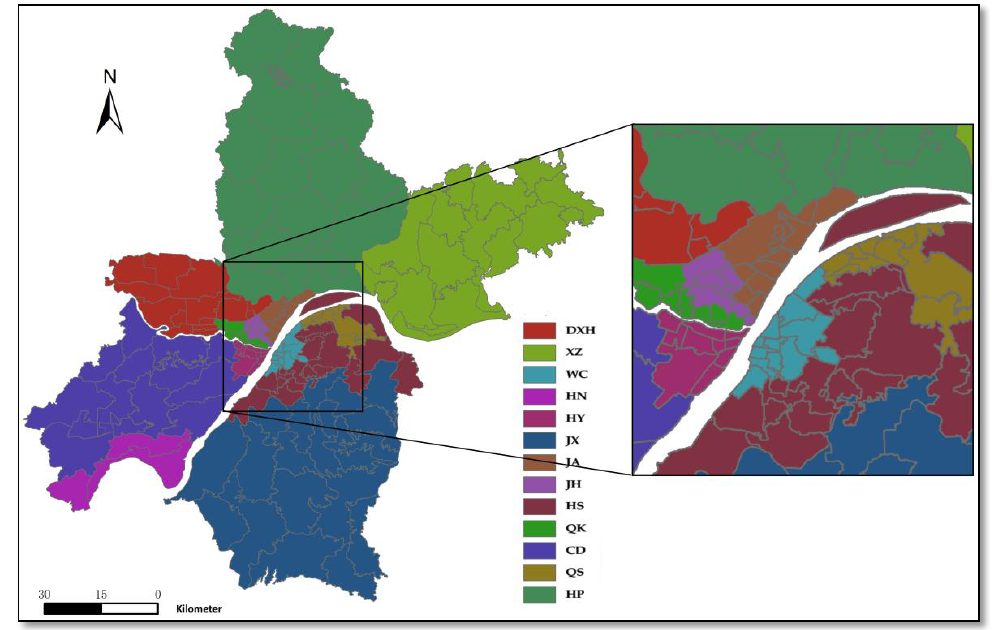
Figure 2. Wuhan’s districts.